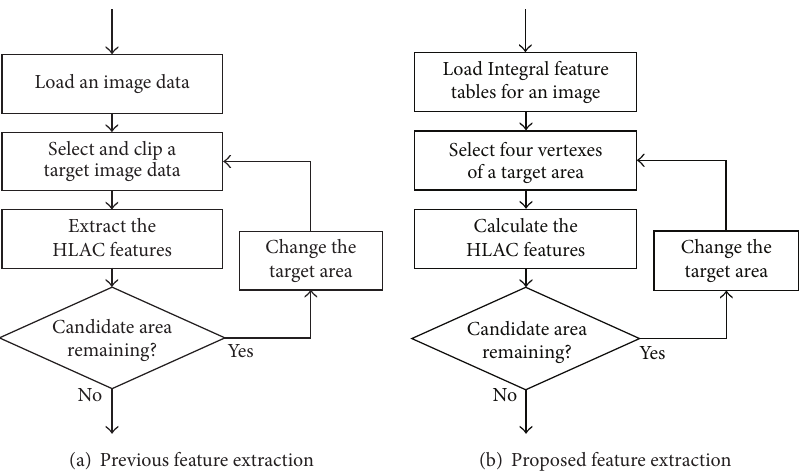
Figure 7: Flowcharts of the HLAC features extraction with/without the integral feature tables for the retrieval